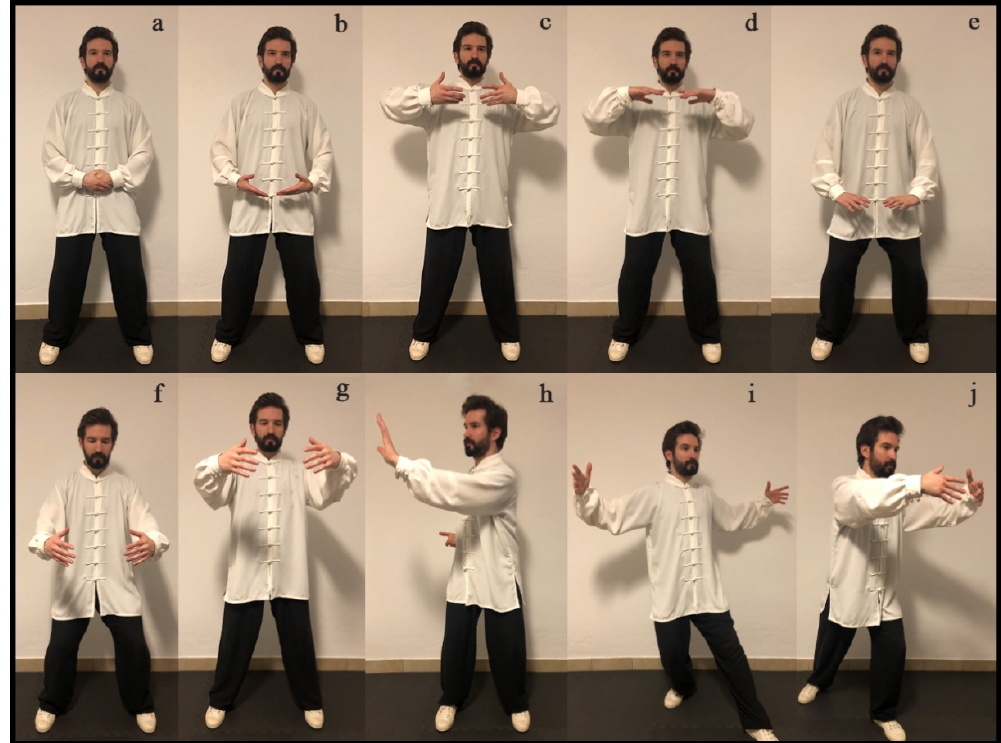
Figure 10. “Qigong” exercises. Sequence ( a – g ): ( a ) focus on the lower “dantian”; ( b – e ) moving the “qi”; ( f ) white ball lower “dantian”; ( g ) white ball middle “dantian”. Sequence ( h – j ): ( h ) “Taiji Qigong” pushing palm; ( i , j ) “Taiji Qigong” spreading the wings.